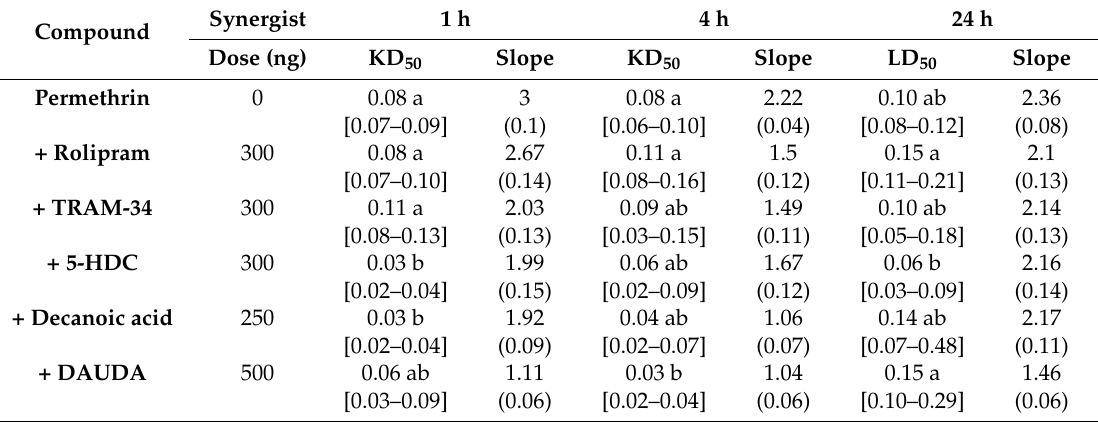
Table 3. Synergistic activity of each compound co-applied with permethrin. KD 50 and LD 50 values with [95% CIs] are given in µ g/mg of adult body weight, and doses co-applied correspond to the 24 h LD 15 of each compound. Values for response slope ( ± SEM) are also shown. Responses were compared to each other according to the 95% CI of the KD 50 or LD 50 . For each time point (column), different letters mean non-overlapping 95% CI, and KD 50 or LD 50 values not labeled by the same letter are different ( p <